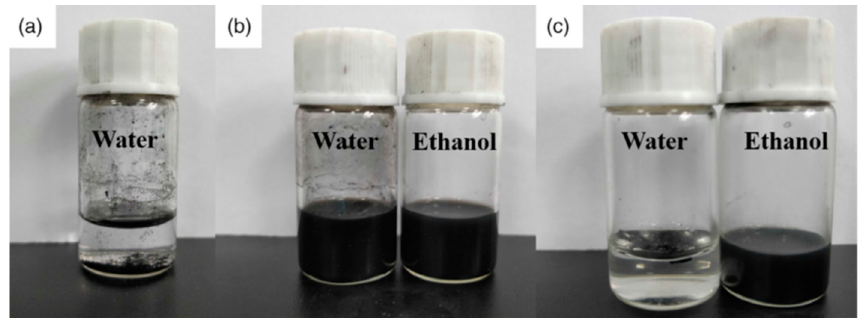
Figure 3. The solubility of CNT ( a ) in water and CNT-Br ( b ) in water and ethanol and CNT-NTf 2 ( c ) in water and ethanol, from left to right with contents of 5 mg in 10 mL solutions. With permission [26].